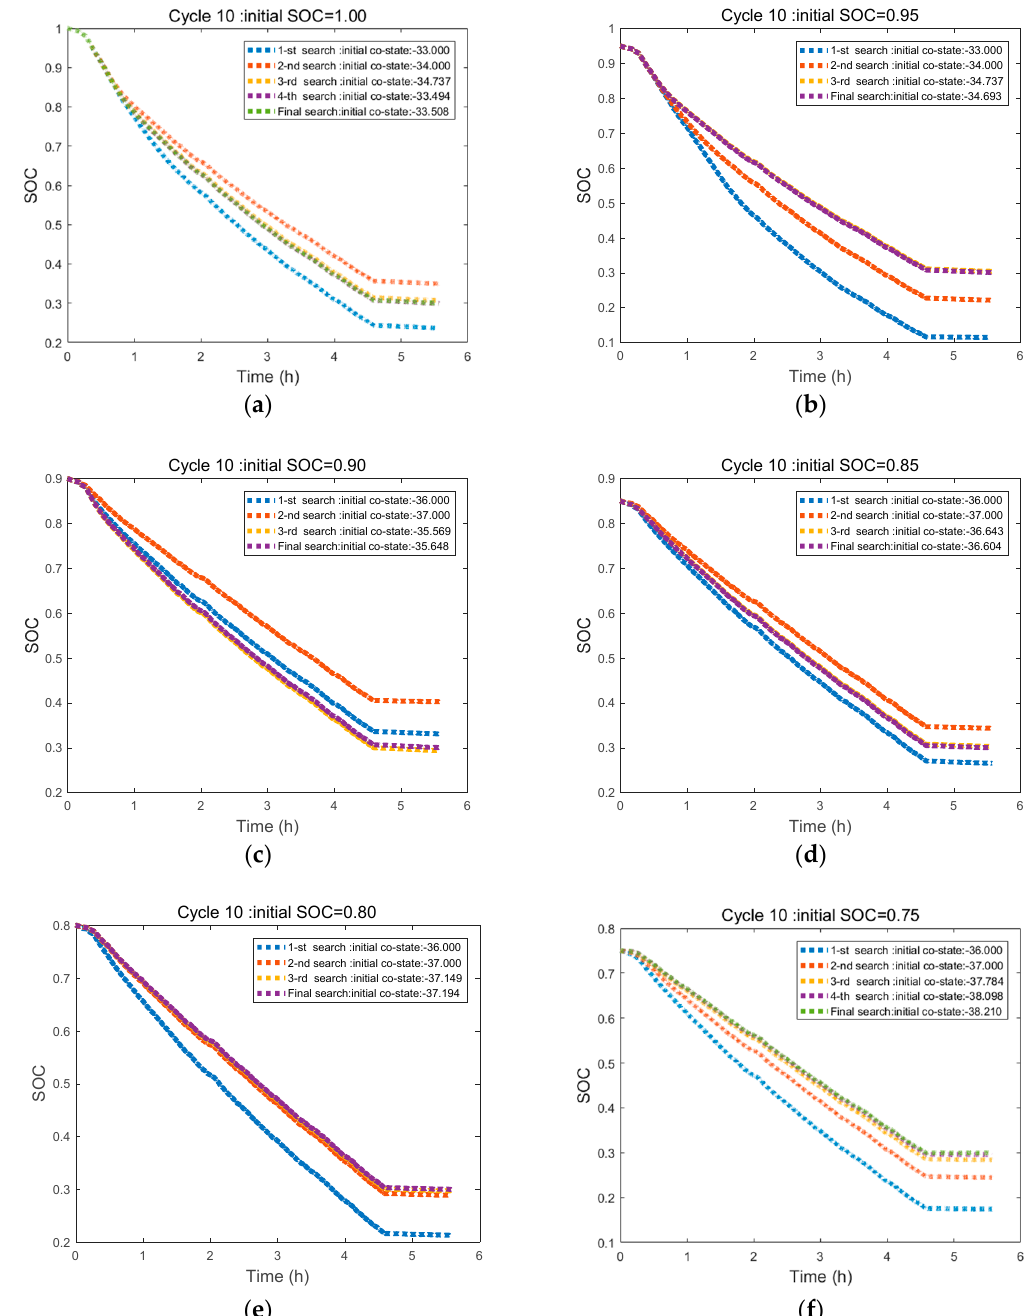
Figure 12. The λ 0 search process of Cycle 10 under different initial SOC.